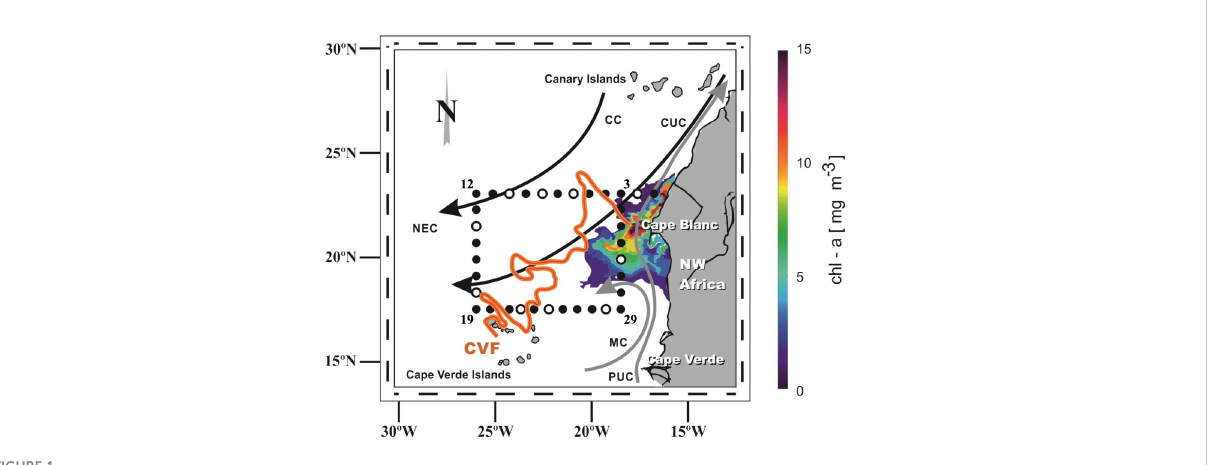
FIGURE 1 Map of the study area and the hydrographic stations sampled during the FLUXES I cruise (modi fi ed from Valiente et al., 2022). Numbers indicate station number; black circles represent the stations where SPE samples were collected and white circles represent stations where SPE samples where not collected. The main currents are represented with arrows: The Canary Current (CC), the Canary Upwelling Current (CUC), the North Equatorial Current (NEC), the Mauritania Current (MC) and the Poleward Undercurrent (PUC). The concentration of chlorophyll a, related to the Cape Blanc giant fi lament (CBGF), is illustrated with color contours near the